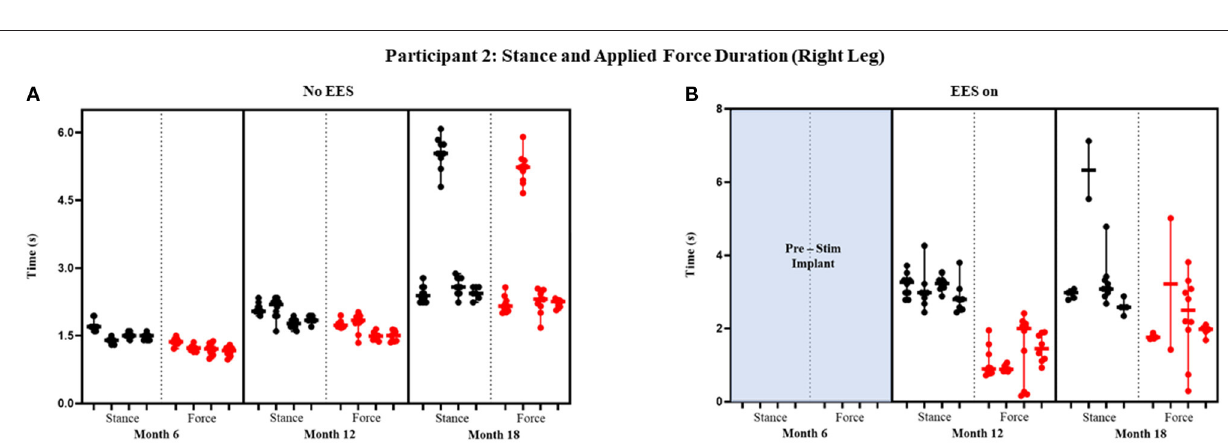
FIGURE 8 | Participant 2: stance and applied force duration right leg. Duration of stance (black dot) and applied force (red dot) with line at the median and range for right leg during no EES (A) and EES on (B) . Each tick in the x-axis represents a dataset of up to 10 consecutive cycles.